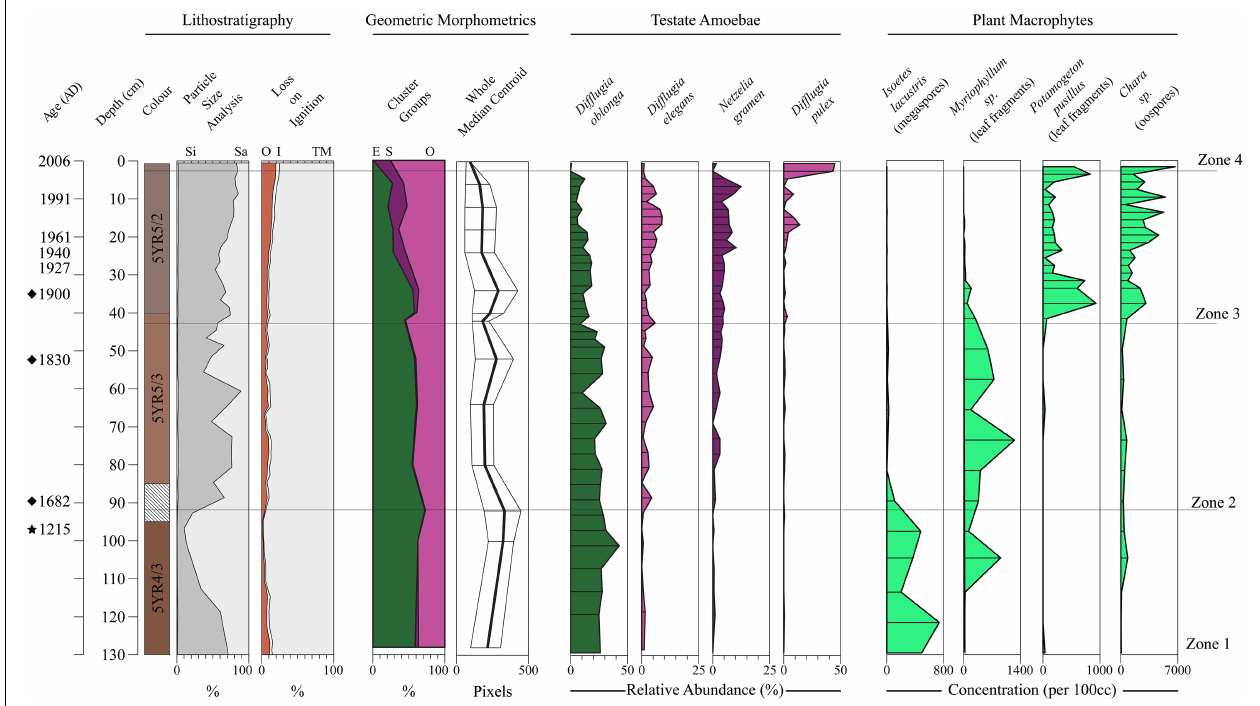
FIGURE 8 | Stratigraphic summary diagram for Loch Leven. Core chronology is based on modeled 210 Pb dates (Salgado et al., 2010), extended 210 Pb model dates (diamonds) and a single radiocarbon date (1215) marked by a star at 96 cm (Prentice et al., 2018). Lithostratigraphic variables are shown as stacked profiles: loss-on-ignition results are percent organic carbon (OC), percent inorganic carbon (IC) and percent minerogenic matter (TM) (Salgado et al., 2010); particle size data as percent silt (Si) and sand (Sa) (Prentice et al., 2018). The percentage of specimens belonging to each shape group identified by cluster analysis of the Whole-PC1 and -PC2 scores are shown as a stacked profile: (O) Ovoid; (S) Spherical; (E) Elongate. Median centroid size of the Procrustes-PCA landmark dataset is displayed as a line graph. Select Arcellinida (Prentice et al., 2018) and plant macrofossil taxa (Salgado et al., 2010) are illustrated. CONISS zones are from the Arcellinida dataset presented by Prentice et al.